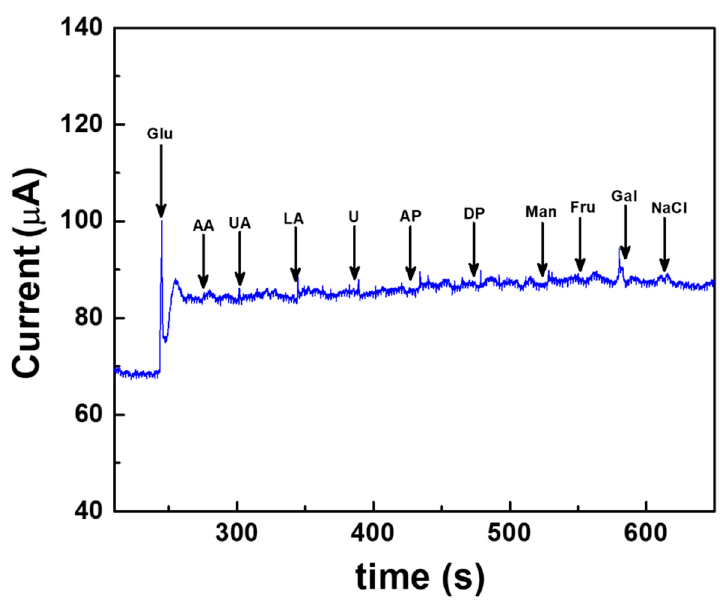
Figure 8. Interference-free measurement of glucose measured using the fabricated wireless device at a fixed external potential of +0.12 V vs. AgCl electrode carried out in a background electrolyte of 100 mM PBS (pH 7.4). The common interfering agents present in real samples such as ascorbic acid (AA), uric acid (UA), lactic acid (LA), urea (U), acetaminophen (AP), dopamine (DP), mannose (Man), fructose (Fru), galactose (Gal) and sodium chloride (NaCl) are spiked at a regular interval of 50 s and at concentrations greater than the physiological levels.